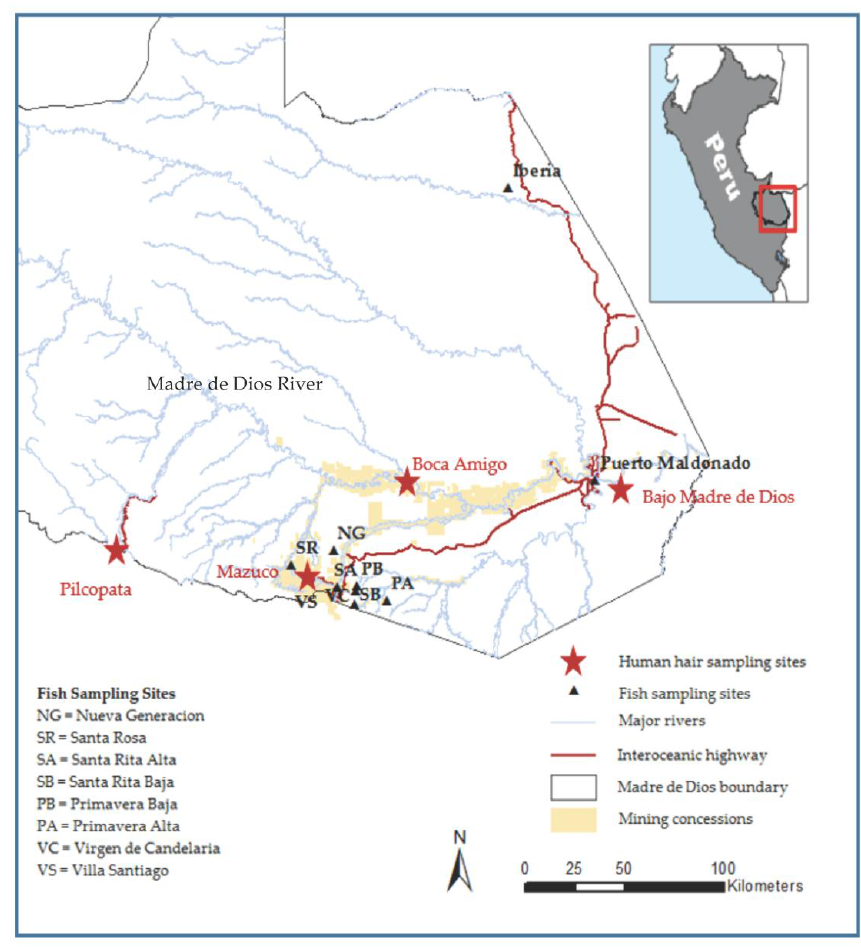
Figure 1. Map of the study site locations in the Madre de Dios river basin of Southeastern Peru. Map created with ESRI ARCGIS software, with layers downloaded from Atrim Biodiversity Information Systems [58]. Table 1. Geographic and mining-related characteristics of four human study sites in the Madre de Dios river basin of Southeastern